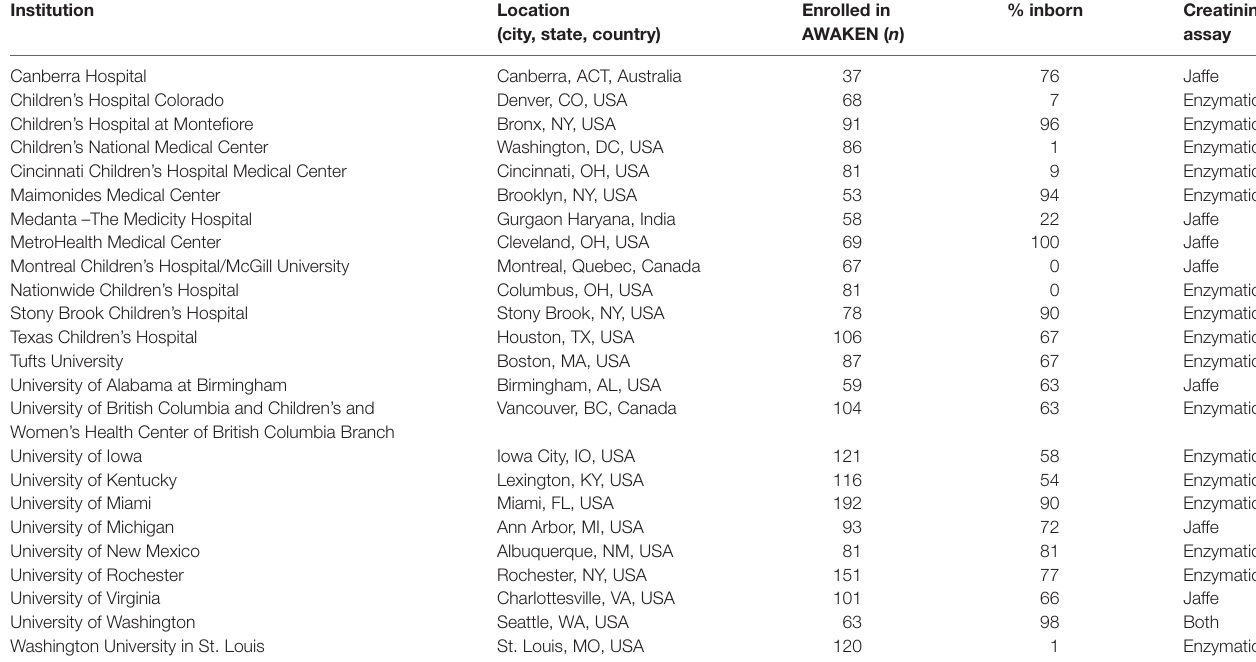
tablE 2 | Participating